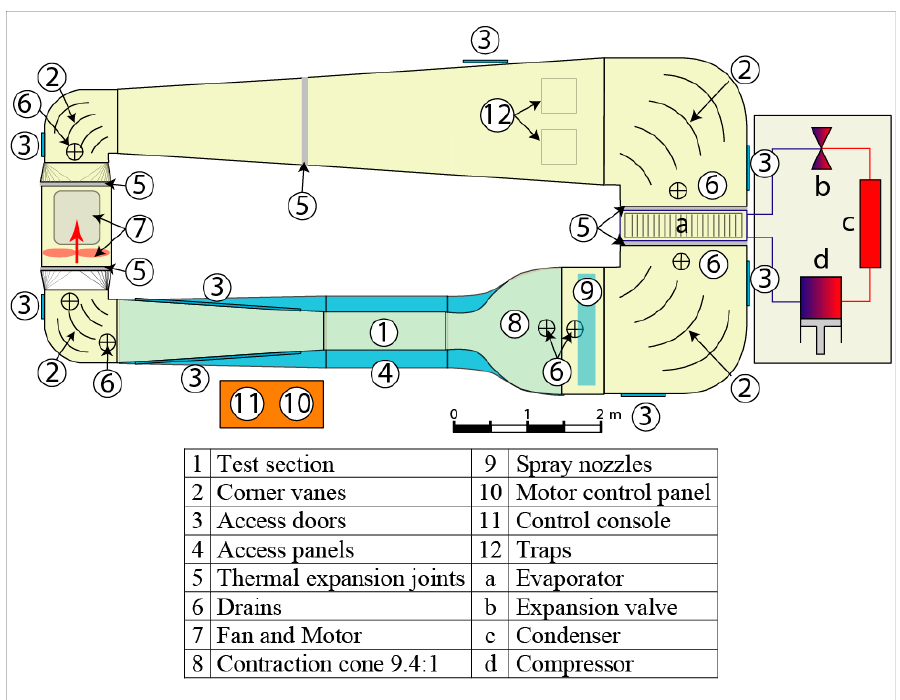
Figure 2. Icing wind tunnel schematic [16].